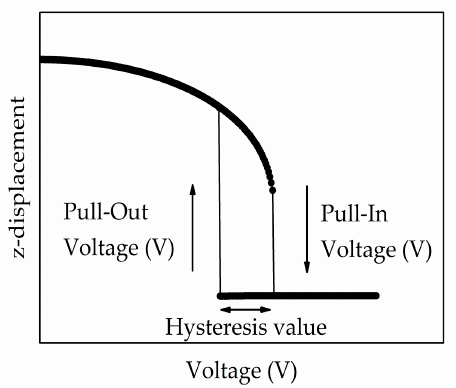
Figure 3. Typical actuation voltages characteristics for pull-in, pull-out voltages, and hysteresis of the graphene-based NEM switch.